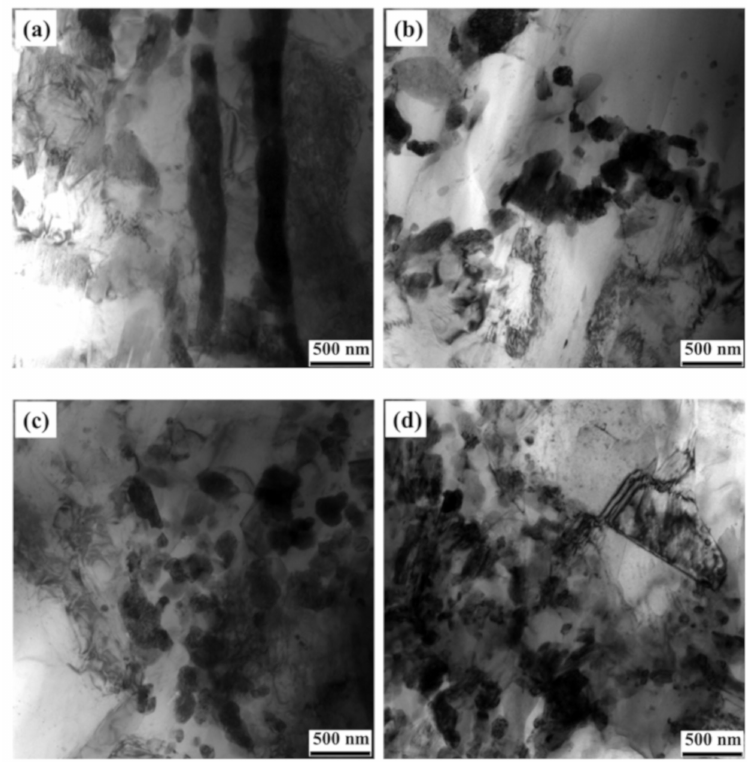
Figure 10. TEM images of Al 2 Ca phase particles in ( a , b ) 623 K-4P, ( c ) 623 K-12P and ( d ) 573 K-12P